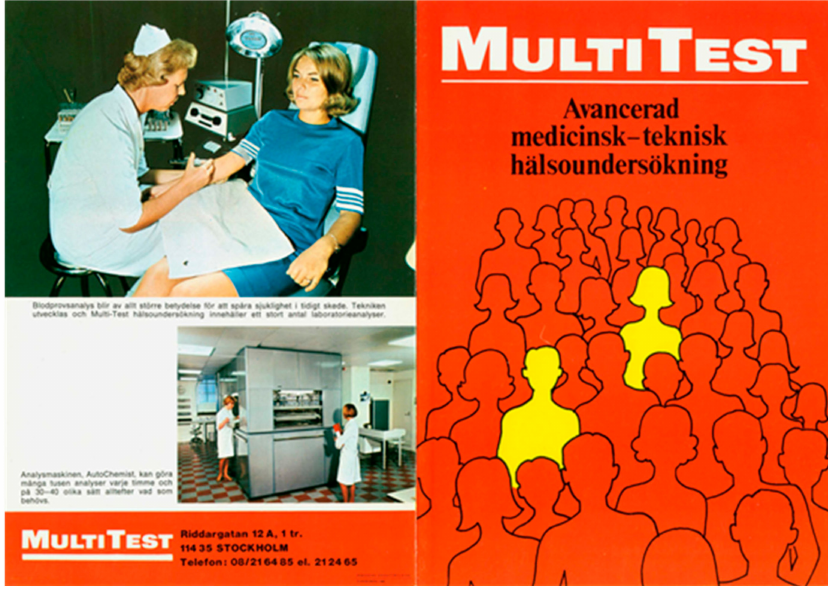
Figure 9. First page of a flyer for the MultiTest Centre described in the text.